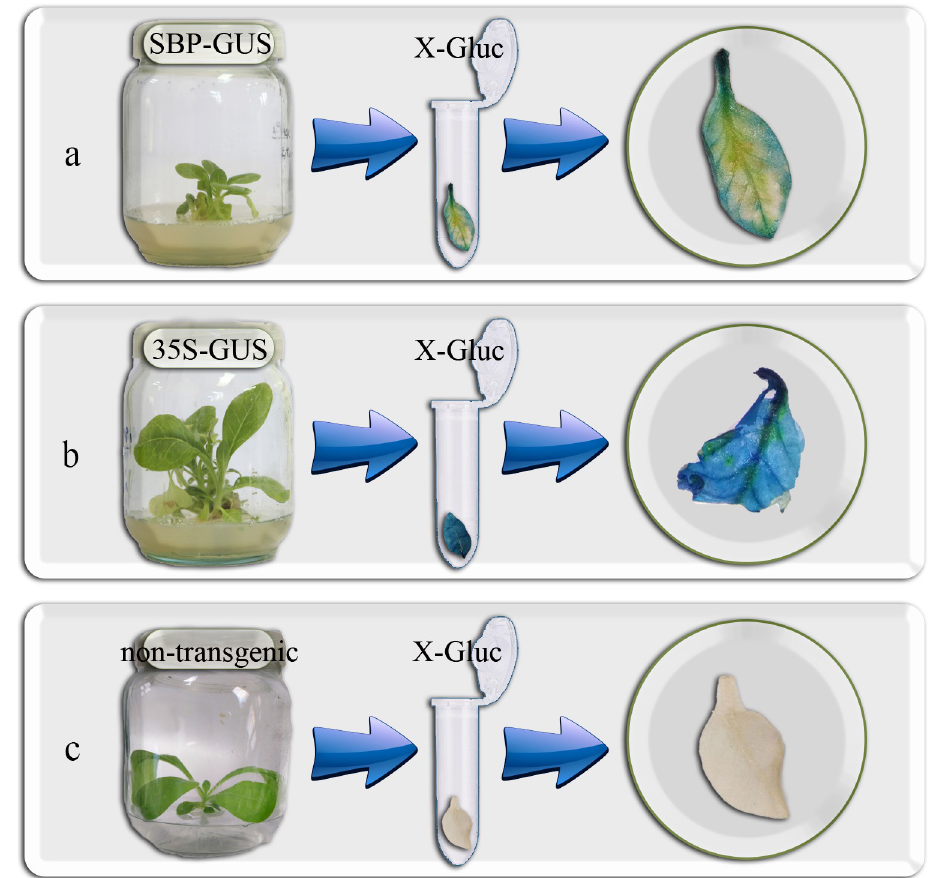
Fig 3. Histochemical GUS analysis of transgenic tobacco plants at T0 generation: a . transgenic plant b . 35S-GUS c. non-transgenic control.